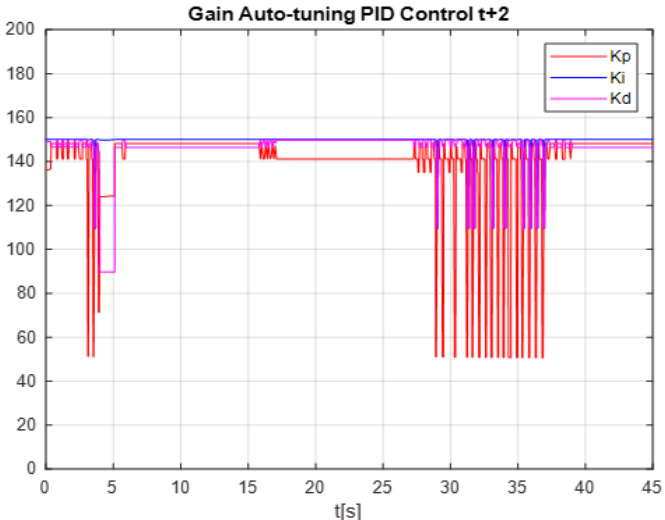
Figure 21. Gain Conventional PID Control.